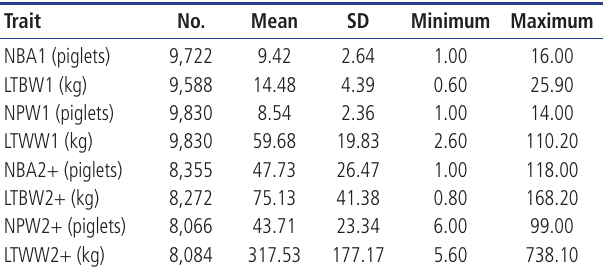
Table 1. Descriptive statistics for first parity and sums from second to last parity reproduction traits Trait